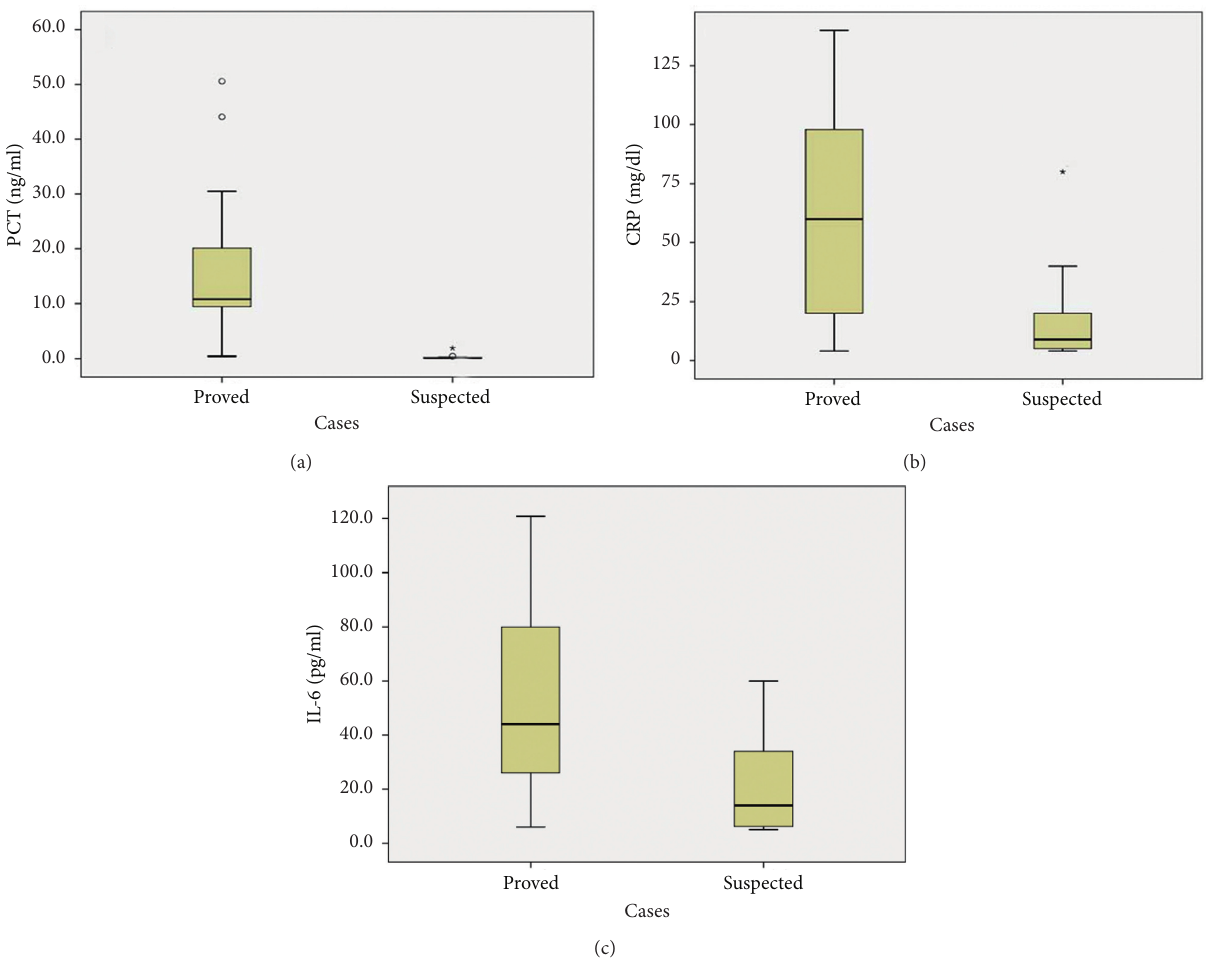
Figure 3: Serum levels of PCT (a), CRP (b), and IL-6 (c) in both proved ( n � 41) and suspected cases ( n � 9). Data are presented as box plots with median lines, 25-, 75- quartiles, and outliers, demonstrating how the data were spread across the range. Table 6: Differences in sepsis markers according to gender. Male group ( n � 33) Female group ( n � 17)